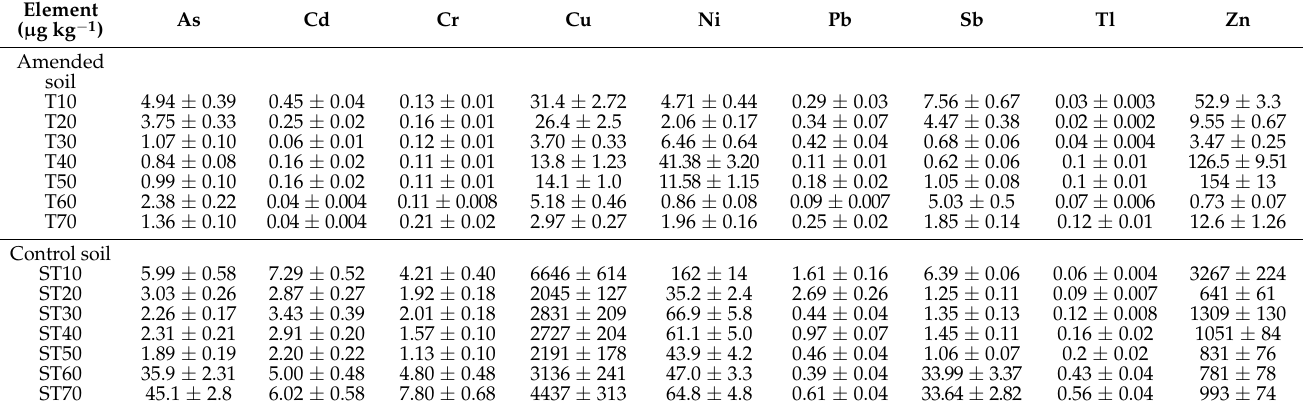
Table 4. Trace element concentrations ( µ g kg − 1 ) extracted with deionized water from amended soil and control soil